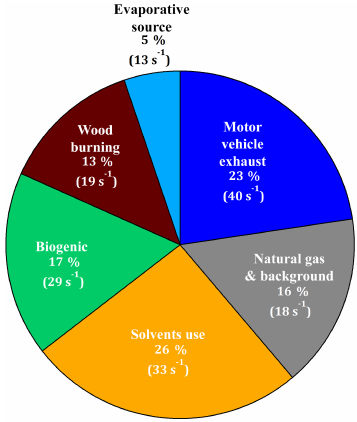
Figure 12. Relative and absolute contributions of reactivity of each PMF factors (percent and per second,